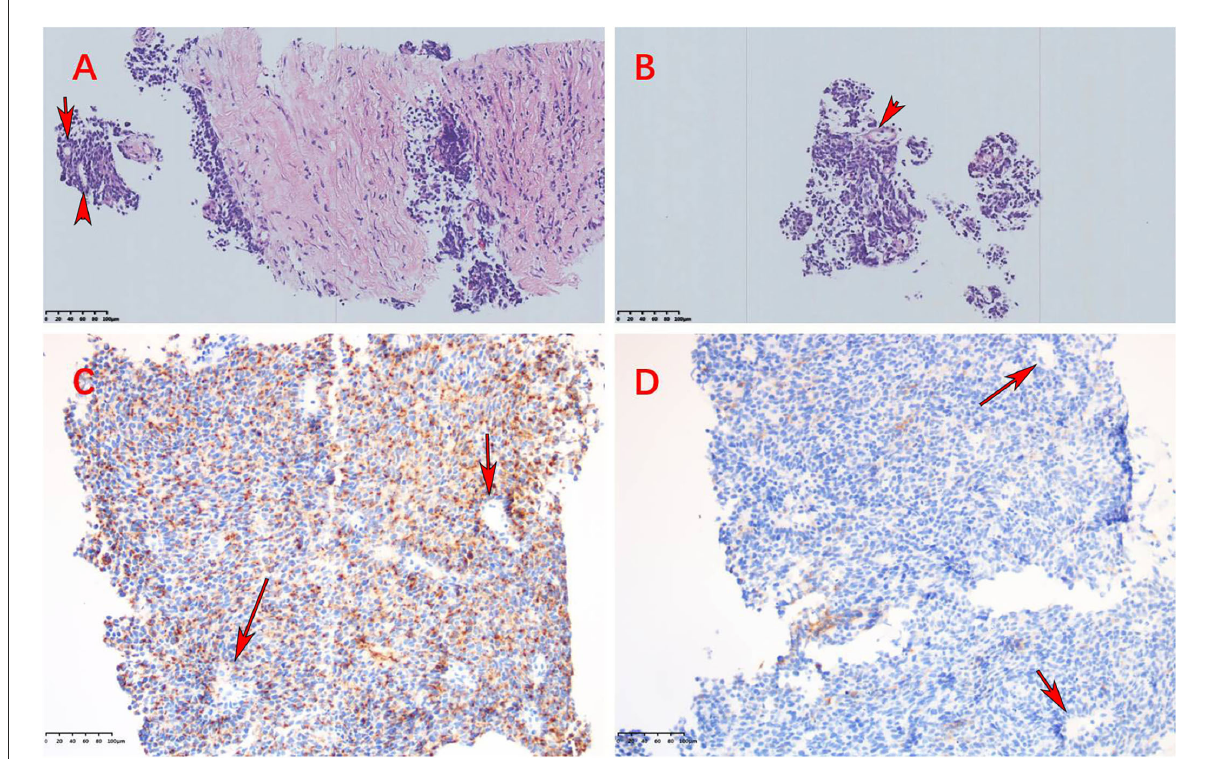
FIGURE4 (A,B) High-power view of lung biopsy histopathology showed irregular multilayered rosettes composed of small round blue cells with atypia, respectively (HE, × 200). (C,D) Immunohistochemical staining was positive for EMA and Syn, respectively ( × 100) (these red arrows indicate multiple